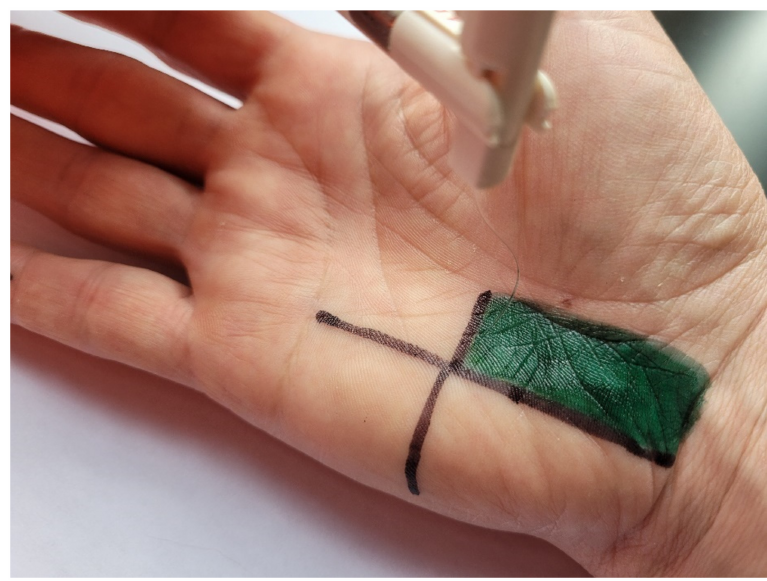
Figure 4. Methodology of testing SWM.